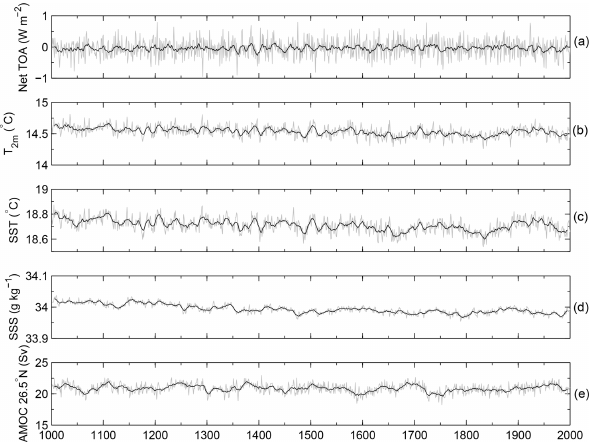
Figure 1. Annual mean time series of global mean (from top to bot- tom) top-of-atmosphere (TOA) net radiation, T 2m , SST, sea surface salinity (SSS), and AMOC strength at 26.5 ◦ N in the PI control run. The grey lines are annual means, whereas the black ones are 10-year running